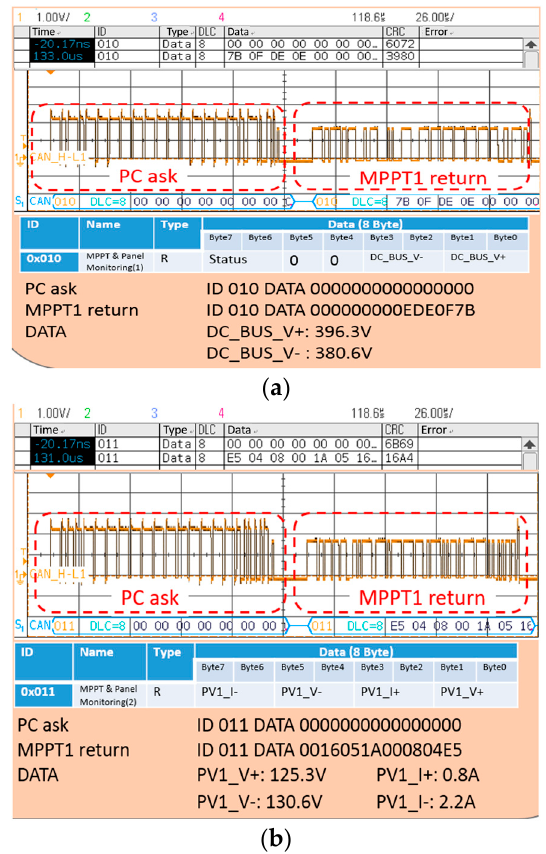
Figure 20. CAN communication waveform ( a ) ID: 0 × 10 ( b ) ID: 0 × 11.